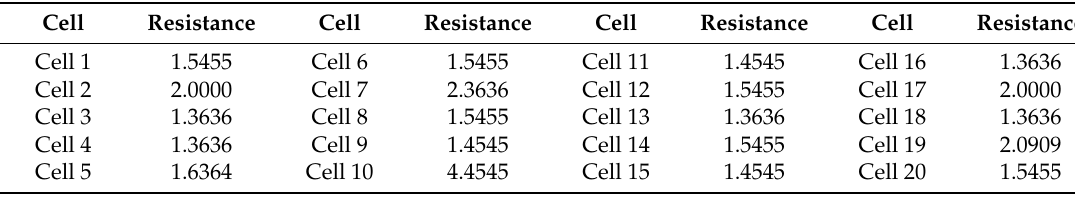
Table 2. Internal resistance of 20 cells (m Ω ).